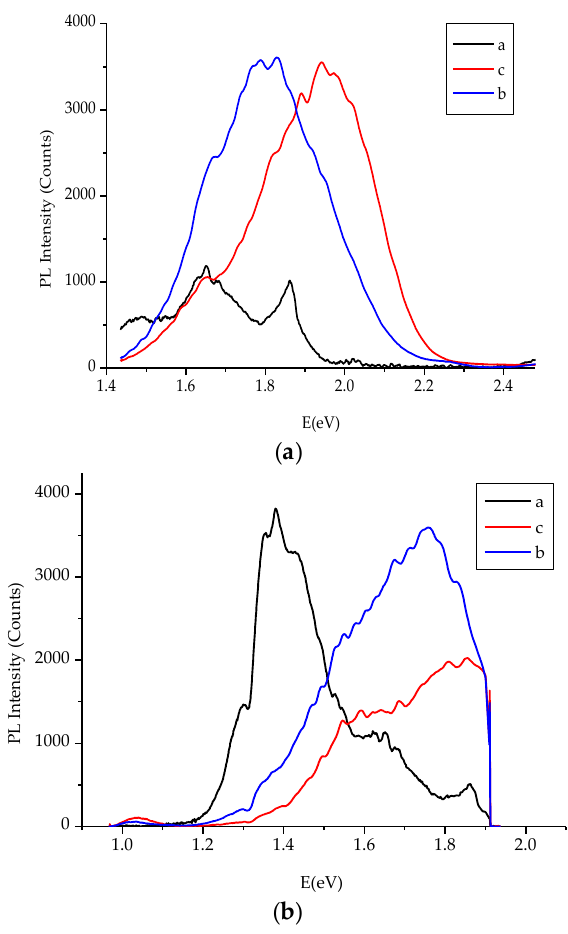
Figure 14. The photoluminescence spectra of CdS 1−y Te y thin films measured at −213 °C . ( a ) Taken by the second grating; ( b ) Taken by the first grating [28].